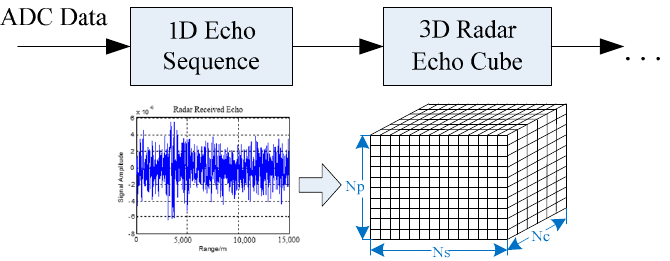
Figure 21. Data preprocessing for a radar echo cube.